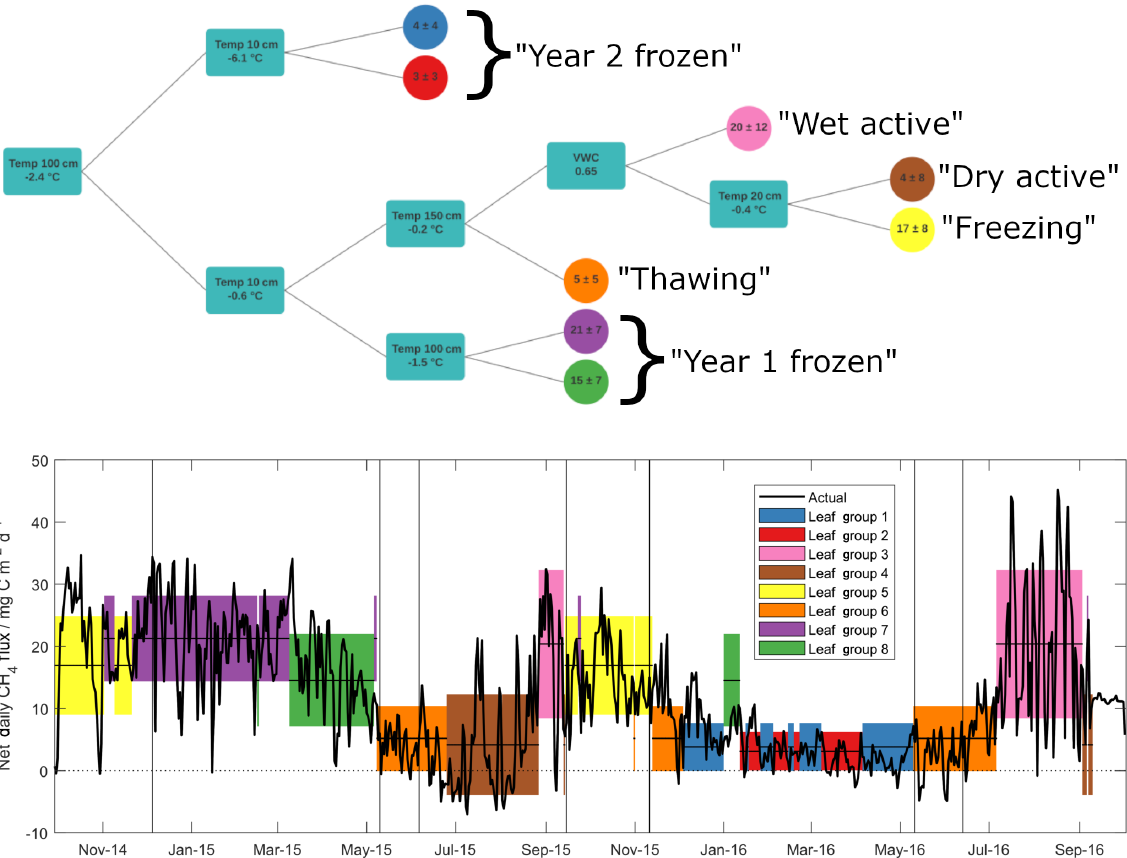
Figure 3. Outcome of the regression tree analysis (upper panel), giving decision steps and outcomes (mean ± standard deviation in mgCm − 2 d − 1 ) of selected methane emission data. Turquoise squares give the variable and thresholds around which decisions are made – lines pointing upwards correspond to values above this threshold and lines pointing down to values below. Lower panel shows net daily methane flux data (black line), along with means (horizontal lines) and standard deviations (shaded regions) of input data, as grouped by the regression tree in upper panel. Note that all methane flux data are net daily